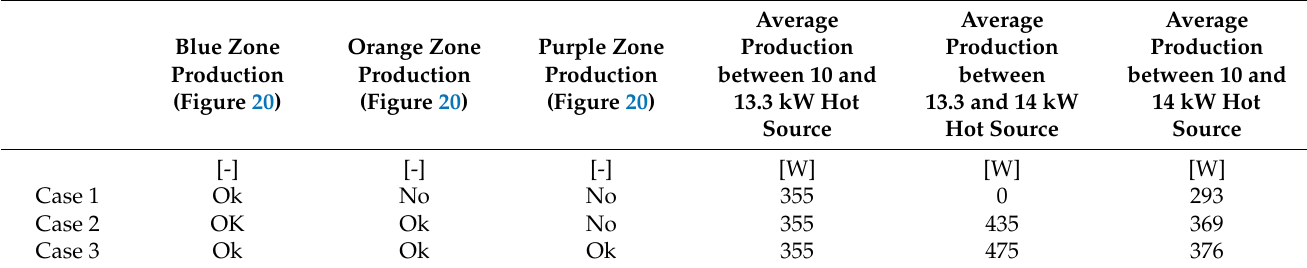
Table 6. Electrical production for case 1, 2 and